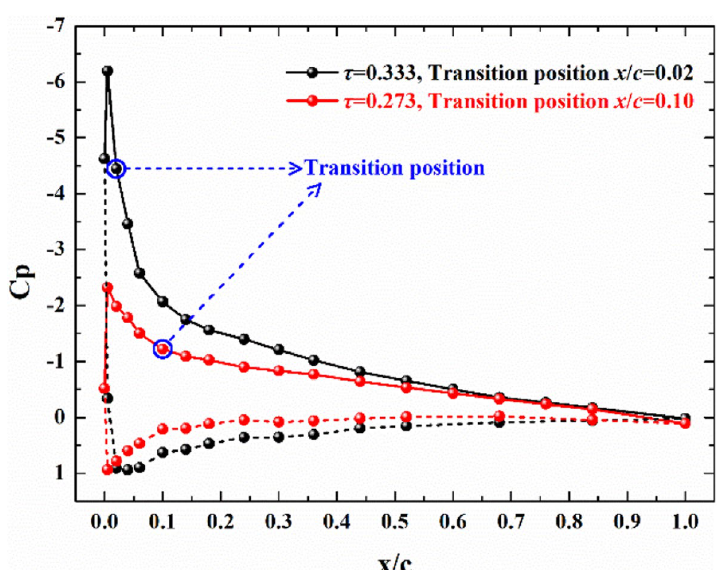
Fig. 7 C p distributions at different